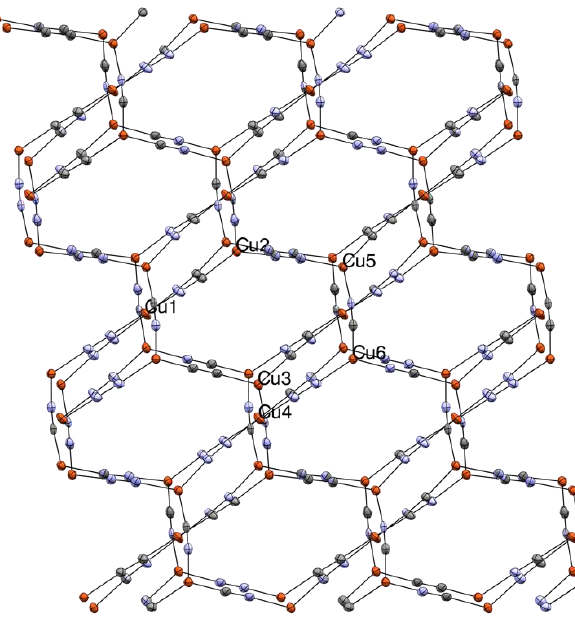
Figure 3. Thermal ellipsoid (50% probability) packing diagram of 2 at 100 K along the c -axis, showing staggered {CuCN} 8 hexagons. Me 4 N + cations and minor occupancy Cu atoms omitted for clarity. Cu orange, N blue, C grey. Selected bond lengths and angles (X = disordered C/N): Cu1-X1 1.857(4), Cu1- X2 1.847(4), Cu1-Cu5 2.9370(9), Cu2-X2 1.931(4), Cu2-X3 1.924(4), Cu2-X4 1.946(4), Cu2-CuA 3.0512(9), 2.9971(9), X1-X1 1.154(6), Cu5-X3 1.947(4), Cu5-X6 1.927(4), Cu5-X7 1.915(4), Cu6-X1 1.944(4), Cu6-X7